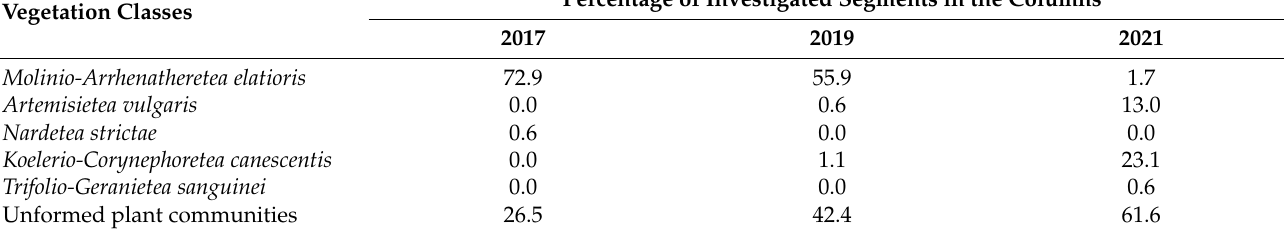
Table 4. Distribution of plant vegetation classes in the segments of the vertical green columns in different years.